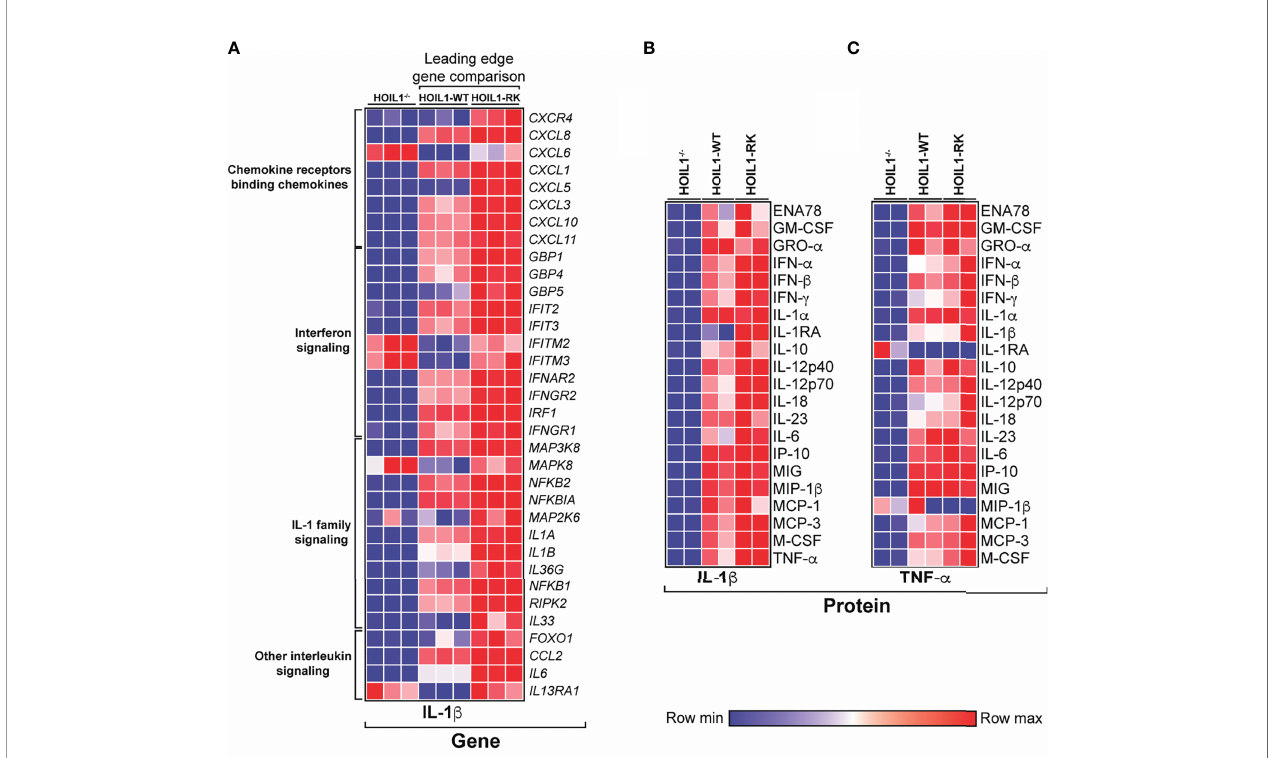
FIGURE 4 | Non-cleavable HOIL1 promotes exaggerated proin fl ammatory cytokine and chemokine production. (A) Heatmap representation of normalized counts of leading edge (LE) genes obtained by GSEA of major cytokine/chemokine-related pathways (Reactome) comparing stimulated HOIL1-R/K vs. HOIL1-WT. Normalized counts for HOIL1 – / – were included for qualitative comparison. (B, C) Heatmap representation of cytokine concentrations 24 h after IL-1 b (B) or TNF- a (C) stimulation of HOIL1 – / – , HOIL1-WT and HOIL1-R/K fi broblasts as measured by 23-plex multiplexed cytokine assays ( N = 2). All heatmaps were row